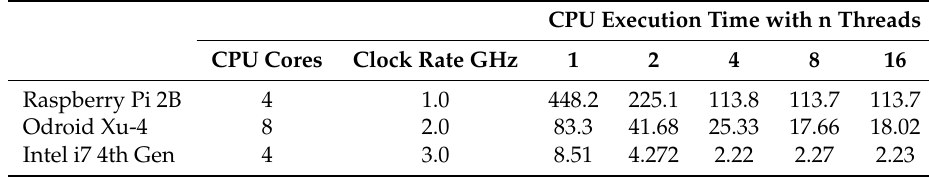
Table 4. CPU execution time (seconds) for individual nodes with n